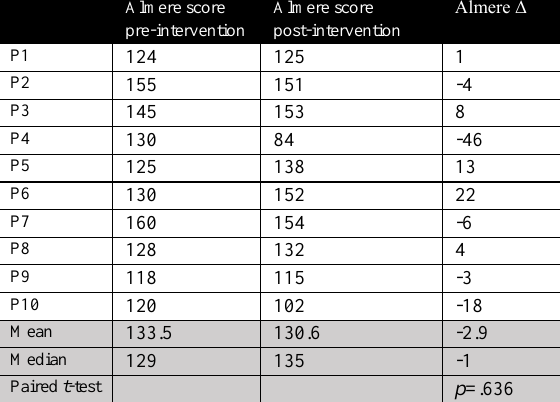
p =.636 Figure 3: Average Godspeed scores for participants with Table 3: Sensor captured interaction time and correlation with change in Almere score pre-post in-home deployment of Paro. Activity% is the total percent of time throughout the day our sensors flagged as interaction, based on the processing described in 3.3.3. Morning% is from the hours of 6am to 12pm, afternoon% from 12pm to 6pm, evening from 6pm to 12am, and overnight from 12am to 6am. The activity% column was calculated by averaging daily activity readings, while the other columns were calculated by averaging weekly readings. *P2 was excluded from analysis as she had incomplete sensor data due to sensor